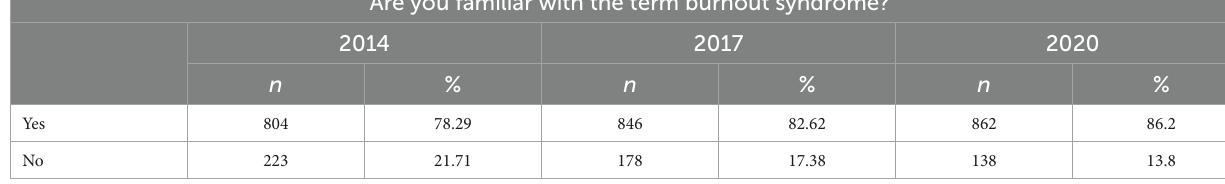
TABLE 1 Knowledge of burnout syndrome. Are you familiar with the term burnout syndrome?